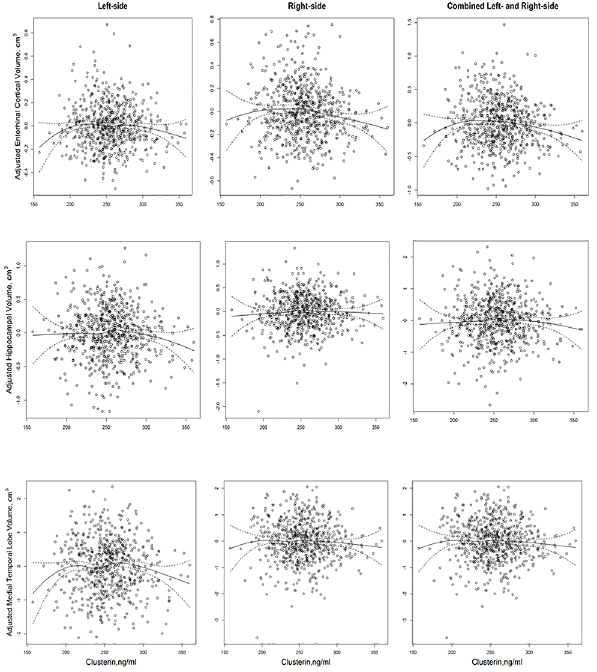
Fig 1. Volume measures of AD-vulnerable brain regions and plasma clusterin. The volume measures include left- side, right-side and combined left and right-side entorhinal cortical volume, hippocampal volume, and medial temporal lobe volume, adjusted for supratentorial brain volume. Plots were fitted with locally weighted smoothing (lowess) functions (95% CI).